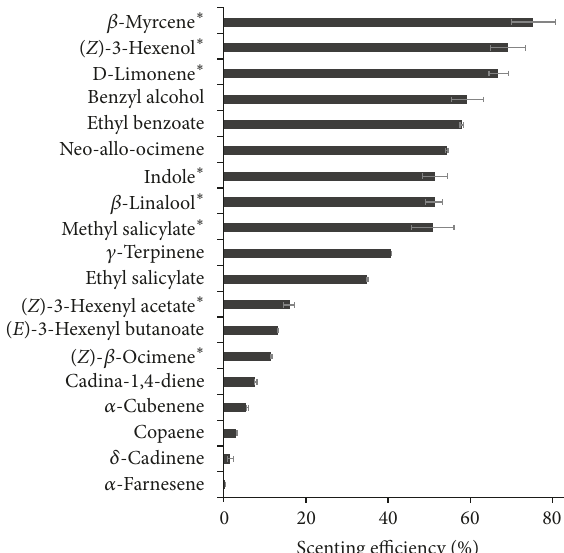
Figure 4: Differential scenting efficiencies of jasmine floral volatiles to the scented green tea. Scenting efficiency was calculated as the percentage of the volatile abundance detected in the scented tea subtracted from that of the same compound in nonscented tea over the abundance of the counterpart present in jasmine flower. Compounds labeled with “ ∗ ”were identified and quantified with authentic